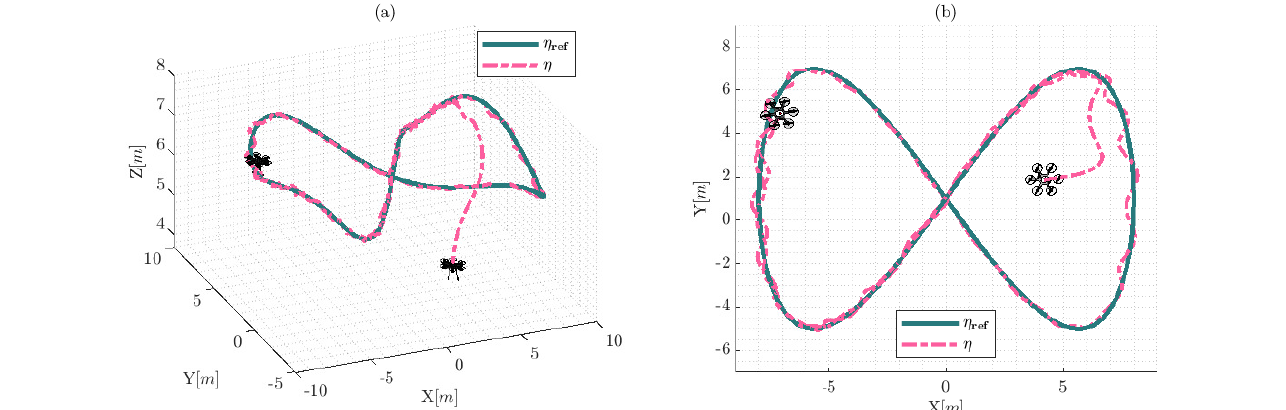
Figure 11. Movements of the hexacopter based on the real-world experimentation: ( a ) represents the behavior of the hexacopter platform using the 3D isometric perspective (cid:8) (cid:9) I x , I y the upper view of the experimental information.